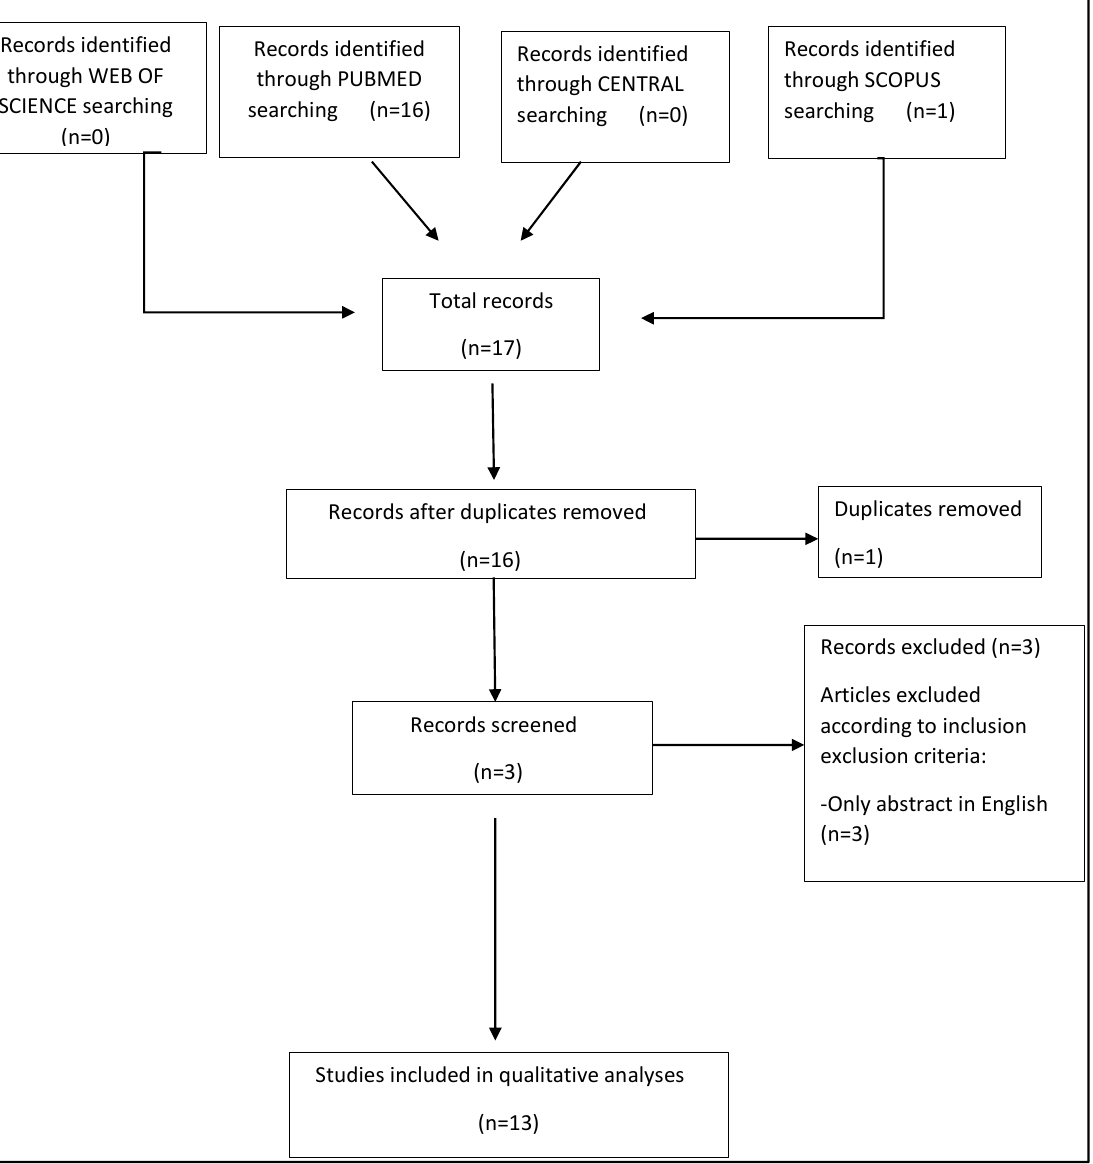
Figure 1. PRISMA flow-chart.